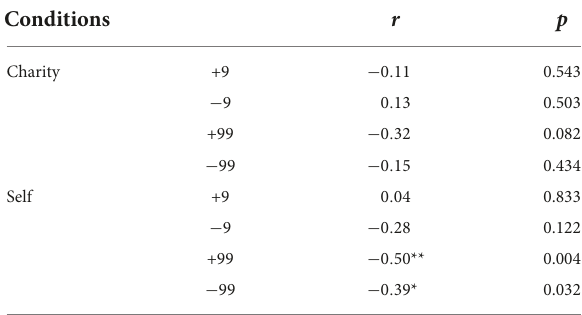
TABLE 2 Correlation analysis